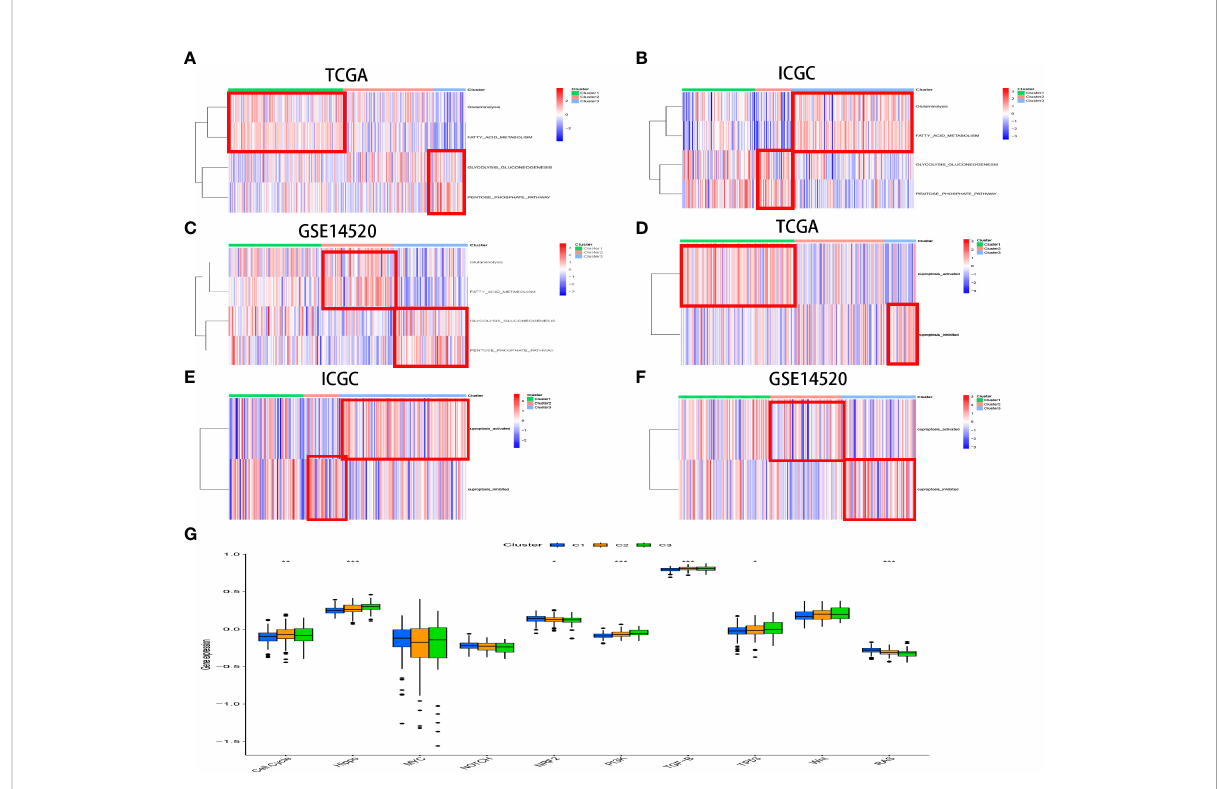
FIGURE 6 The different activated statuses of metabolism pathways among different CR clusters was exhibited by ssGSEA in the TCGA (A) and ICGC (B) cohorts and GSE14520 (C) . The distinct statuses of cuproptosis activity among different CR clusters was exhibited by ssGSEA in the TCGA (D) and ICGC (E) cohorts and GSE14520 (F) . The boxplot illustrates score variations in 10 vital cancerogenic signaling pathways between the CR clusters (G)